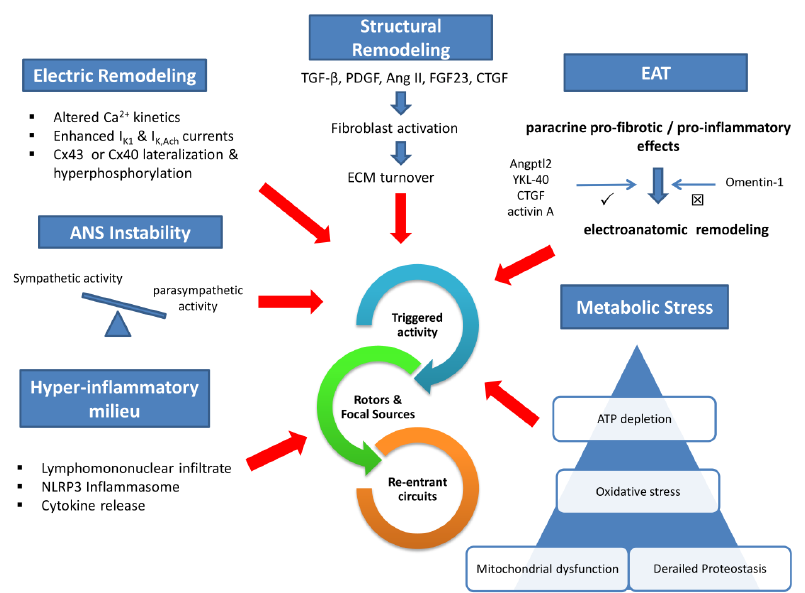
Figure A1. Central Illustration Legend: Six overlapping and interlinked (not shown) pathways are implicated in atrial fibrillation pathophysiology: electric remodeling, structural remodeling, autonomic instability, hyperinflammatory milieu, metabolic stress, and epicardial adipose tissue paracrine effects. The common endpoint is the initiation and maintenance of arrhythmic events. I K1 — inwardly rectifying potassium current; I K,Ach — acetylcholine-activated potassium current; ANS — autonomic nervous system; Cx — connexin; TGF- β—tissue growth factor β; PDGF— platelet-derived growth factor; AngII — angiotensin II; FGF23 — fibroblast growth factor 23; CTGF — connective tissue growth factor; ECM — extracellular matrix; EAT — epicardial adipose tissue; Angptl2 — angiopoietin-like protein 2.